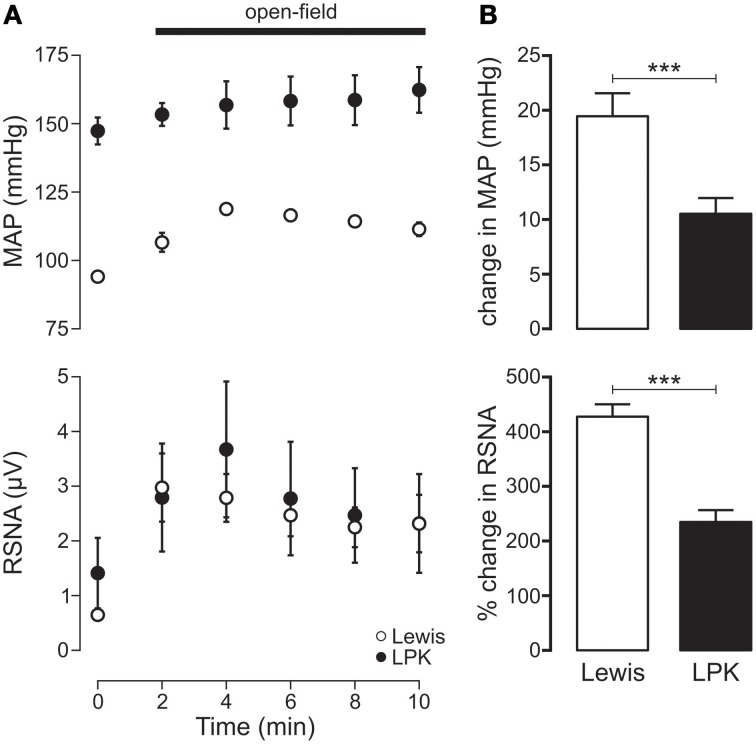
(A) Mean arterial pressure (MAP) and renal sympathetic nerve activity (RSNA) responses to acute open-field stress in Lewis and Lewis Polycystic Kidney (LPK) rats. Data points are 2-min averages of RSNA and MAP measured for 2 min before (time zero) and the first 10 min during acute stress exposure. (B) Average change in MAP and RSNA during the first 10 min of the acute stress exposure. Results are expressed as mean ± SEM. ***p < 0.001. Minimum n/group = 6.